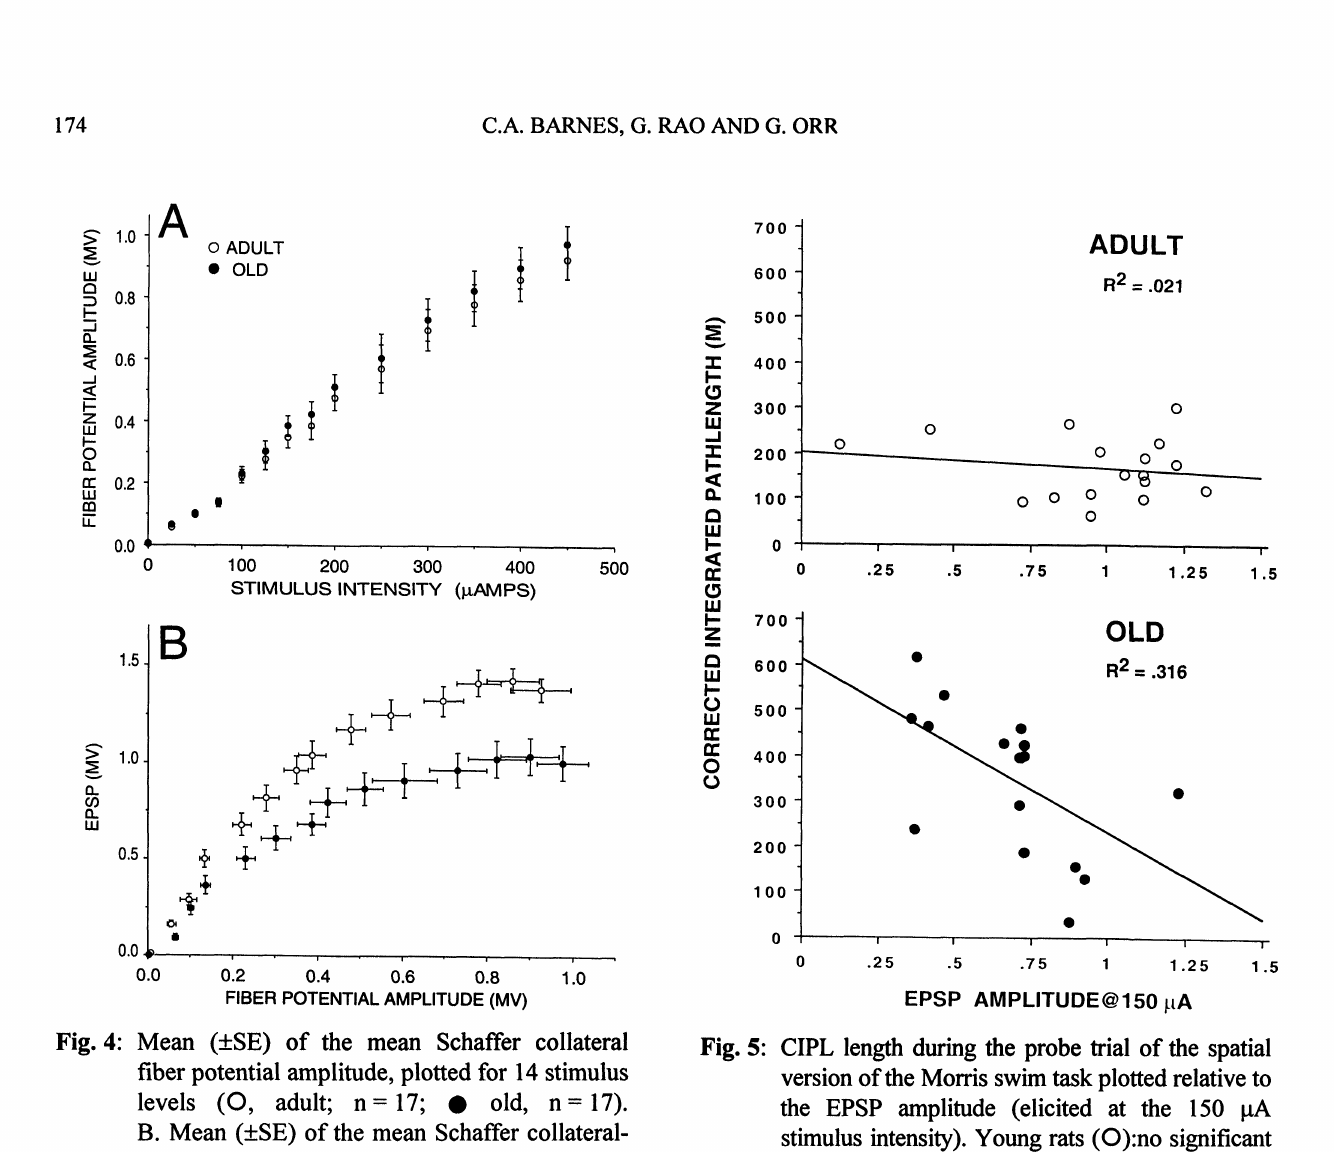
Fig. 4: Mean (+SE) of the mean Schaffer collateral fiber potential amplitude, plotted for 14 stimulus levels (O, adult; n=17; old, n=17). B. Mean (+SE) of the mean Schaffer collateral- CA1 evoked EPSP plotted relative to the mean fiber potential amplitude.